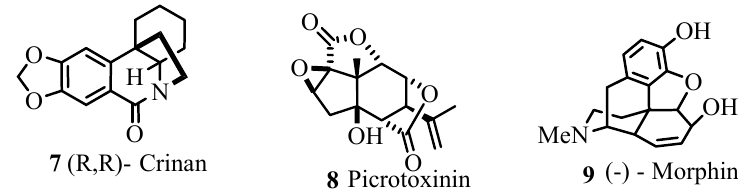
Figure 2. Enantioselective construction of complex natural products reviewed by de Meijere and Meyer [13].